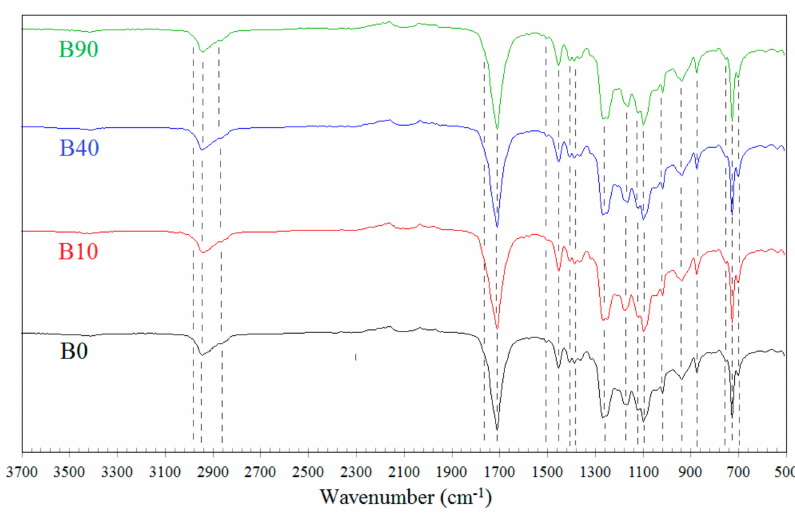
Figure 3. Results of the FTIR measurements of the samples type